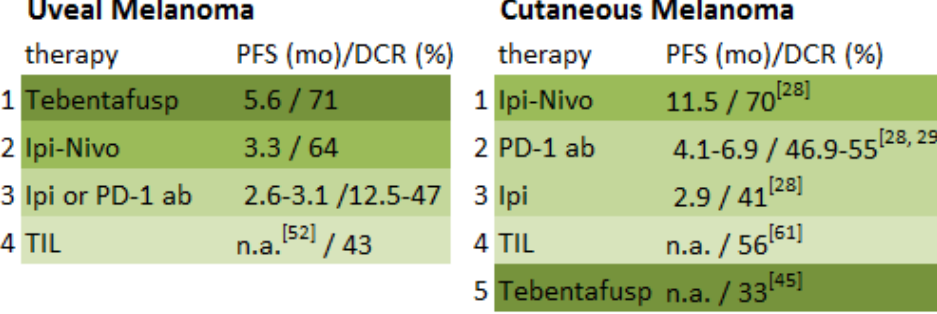
Figure 2. Overview of best evidence to date for immunotherapeutic treatment in uveal melanoma compared to cutaneous melanoma [61].